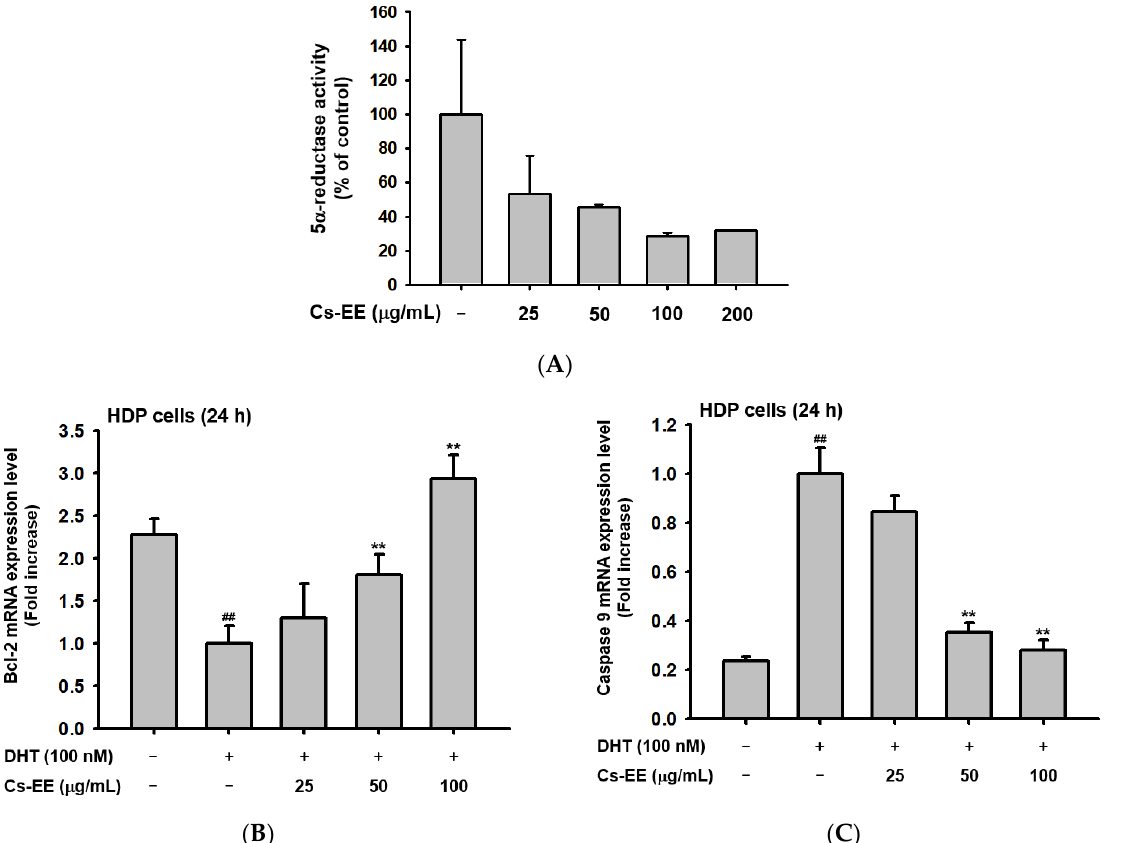
Figure 6. Cs-EE downregulated 5α-reductase activity and regulated the mRNA expression of apop- totic genes in HDP cells. ( A ) The activity of 5α-reductase in Sprague Dawley rats was checked with several concentrations of Cs-EE. ( B , C ) Quantitative real-time PCR was performed to assess the gene regulation effect of Cs-EE on apoptotic pathways. ## p < 0.01 compared with the normal group ** p < 0.01 compared with the DHT-treated group.